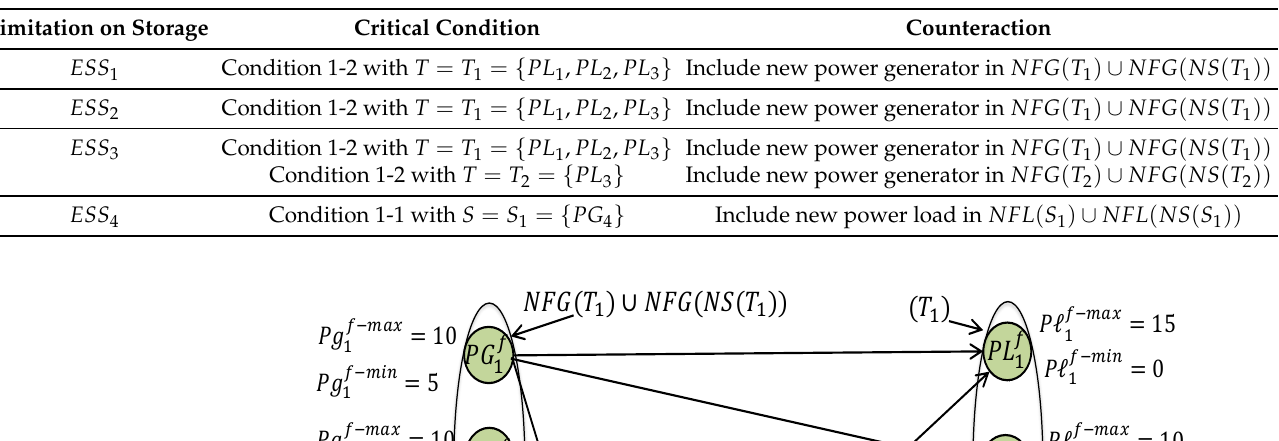
Table 3. Critical condition and counteraction.